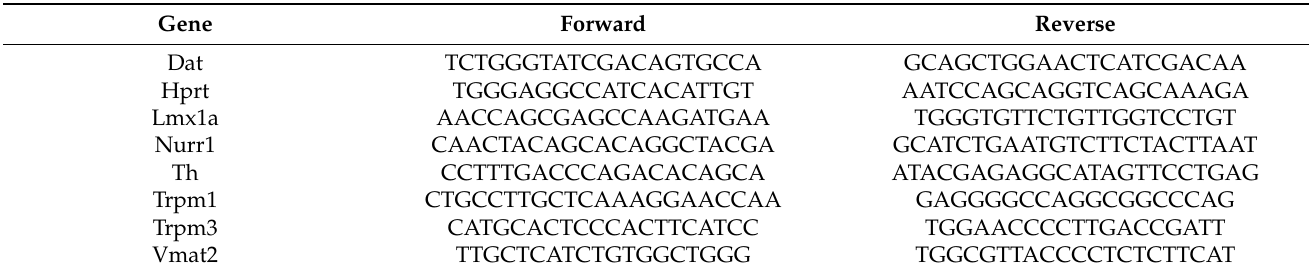
Table 1. Primer’s nucleotide sequence (5 (cid:48) -3 (cid:48) ) used for